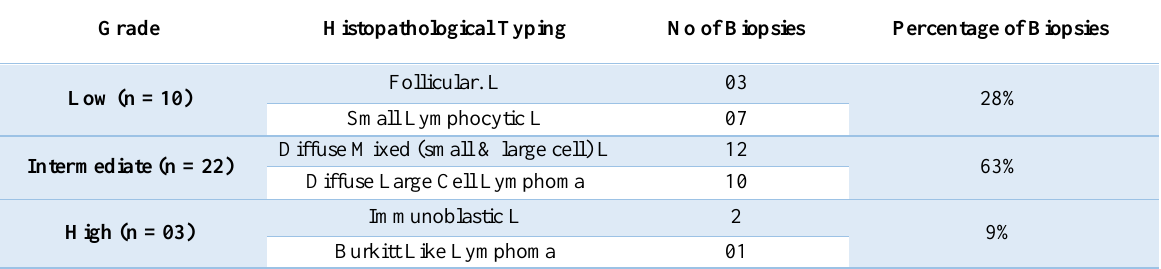
Table 3. Histopathological Typing of Non Hodgkin Lymphomas Biopsies According to the Working Formulation Classification